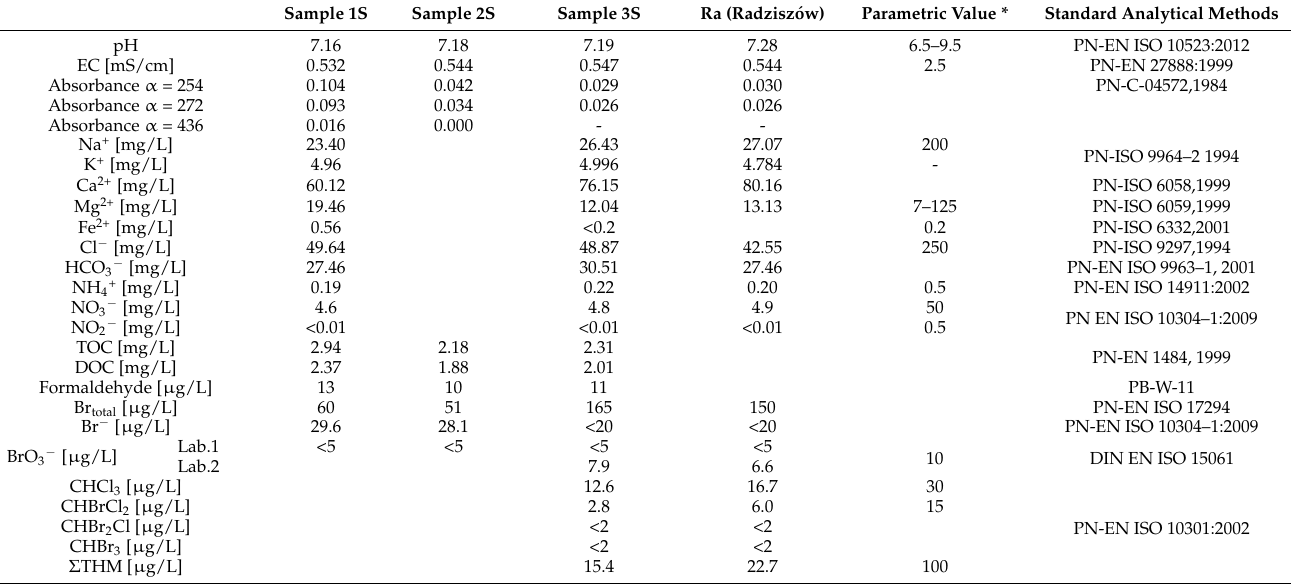
Table 2. Selected physico-chemical parameters of water from the WTP Skawina treated with chlorine exclusively (sample collected on 8 May